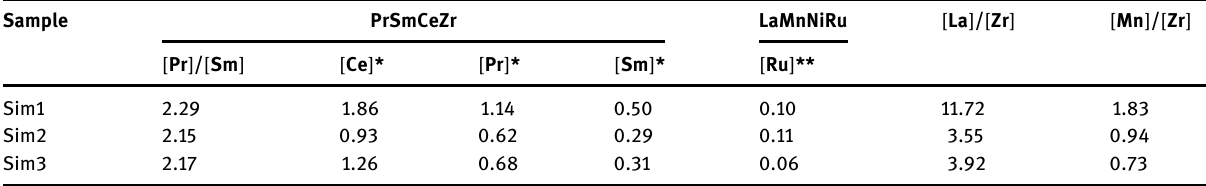
Table 3: Atomic ratios of elements in the near - surface layer Sample PrSmCeZr LaMnNiRu